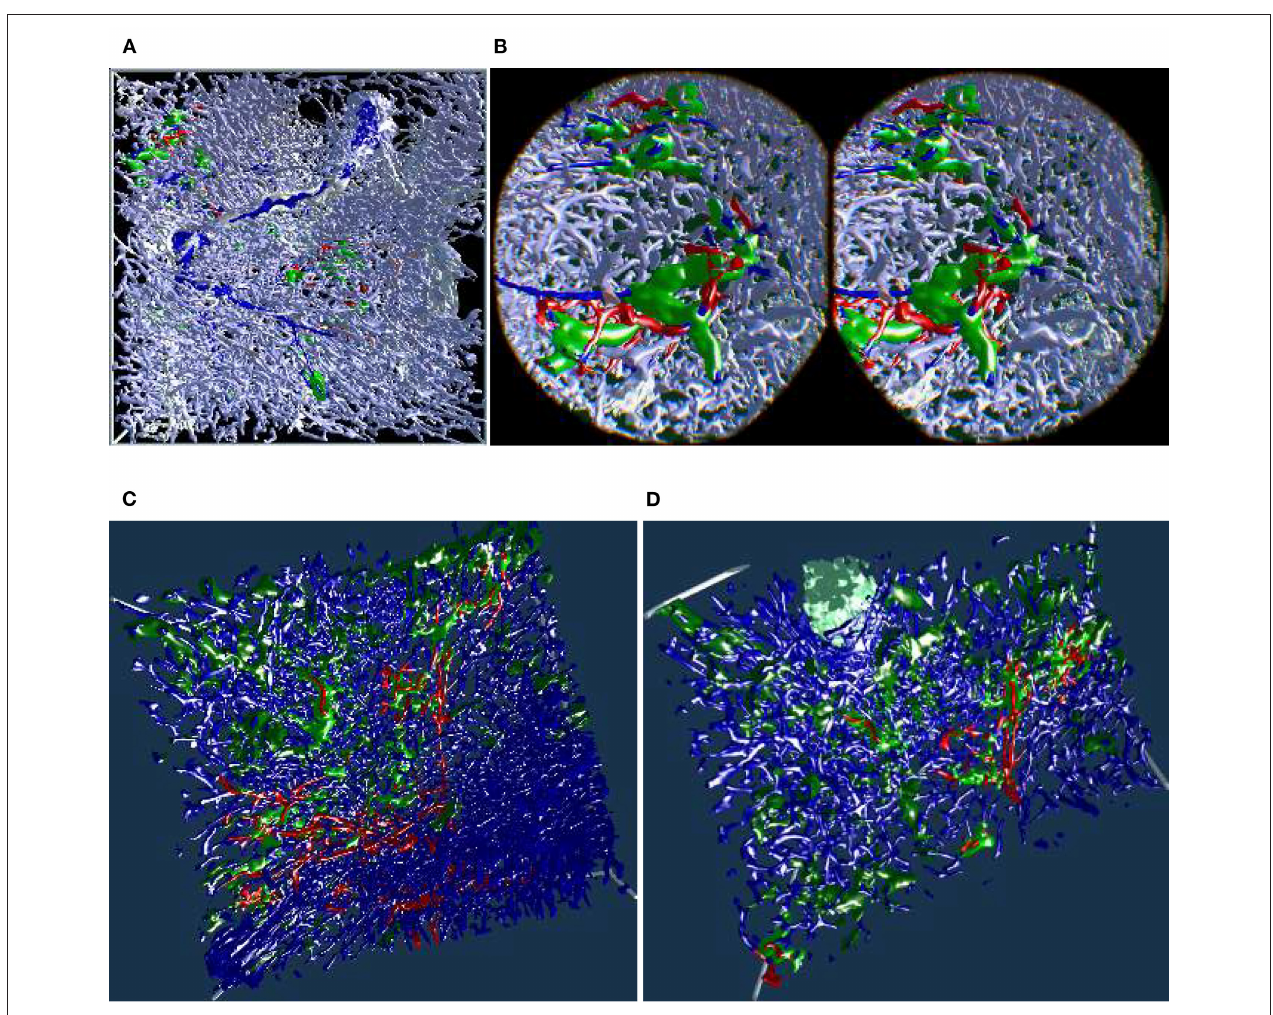
FIGURE 10 | Showcasing front plane clipping on “sheaths alternating” data sets (Steiniger et al., 2021). (A) A complete data set in a frontal visualization. (B) The user cuts into objects of interest using clipping. (C,D) Utilization of clipping during the exploration of the data set. All images are produced with our VR tool either directly or with Steam VR interface. (A,B) were featured in a poster ( Lobachev et al., 2019). (A,C,D) Similar illustrations can be found in Steiniger et al.